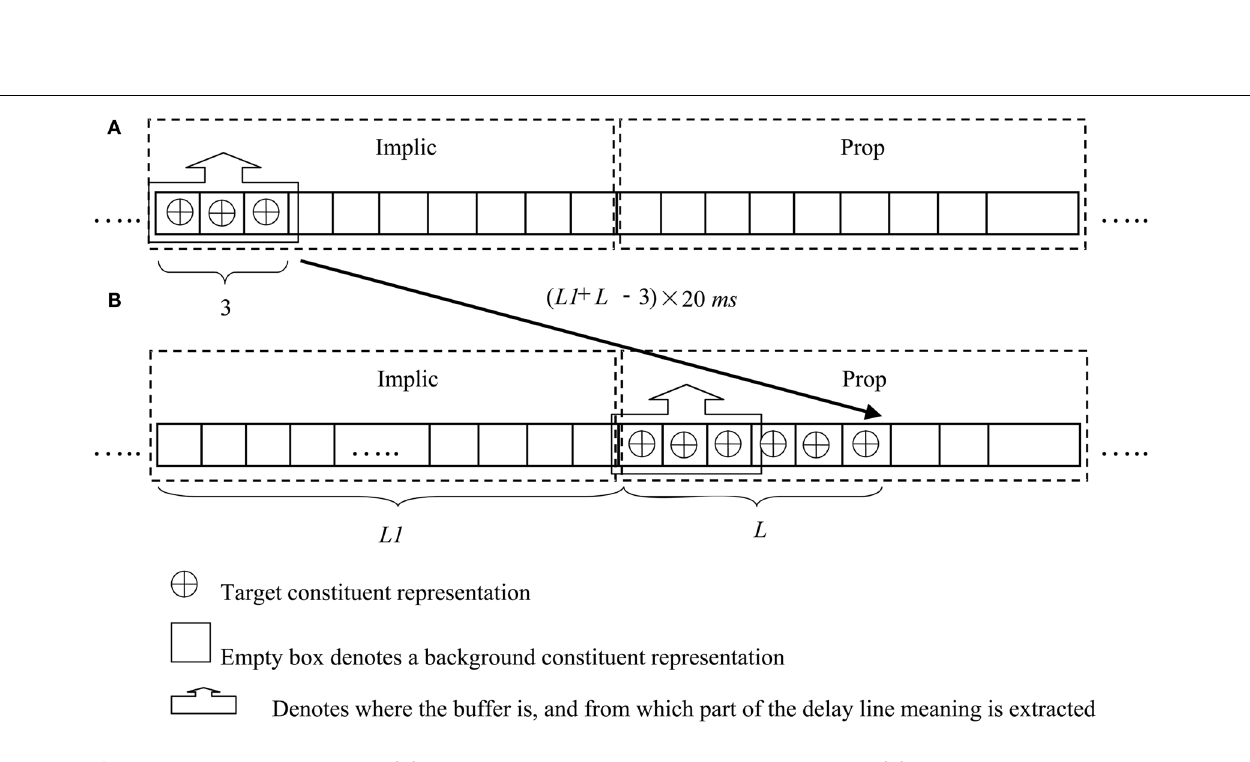
representations of the target; (B) the buffer actually moves just after the last three constituent representations of the target have entered Prop.